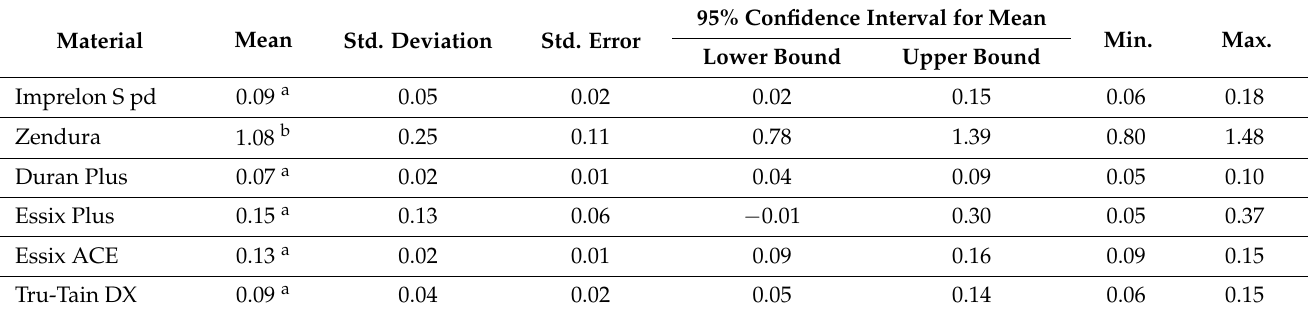
Table 7. Descriptive analysis of roughness values of Group 2 (the same small letter indicates no significant difference between the materials at p < 0.05 level).